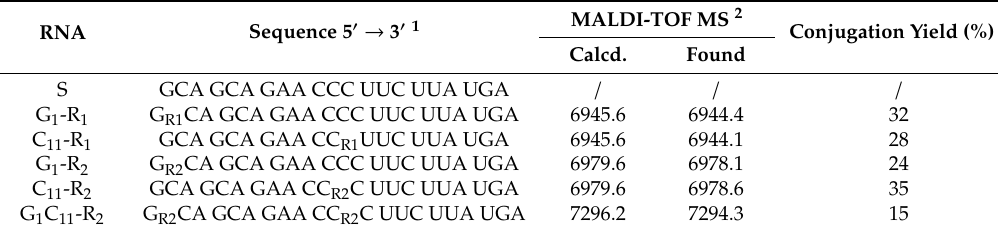
Table 1. Sequence, mass spectrometry data and yields of 2 (cid:48) - O -PySS R 1 SSMe and 2 (cid:48) - O -PySS R 2 SSMe RNAs prepared in this